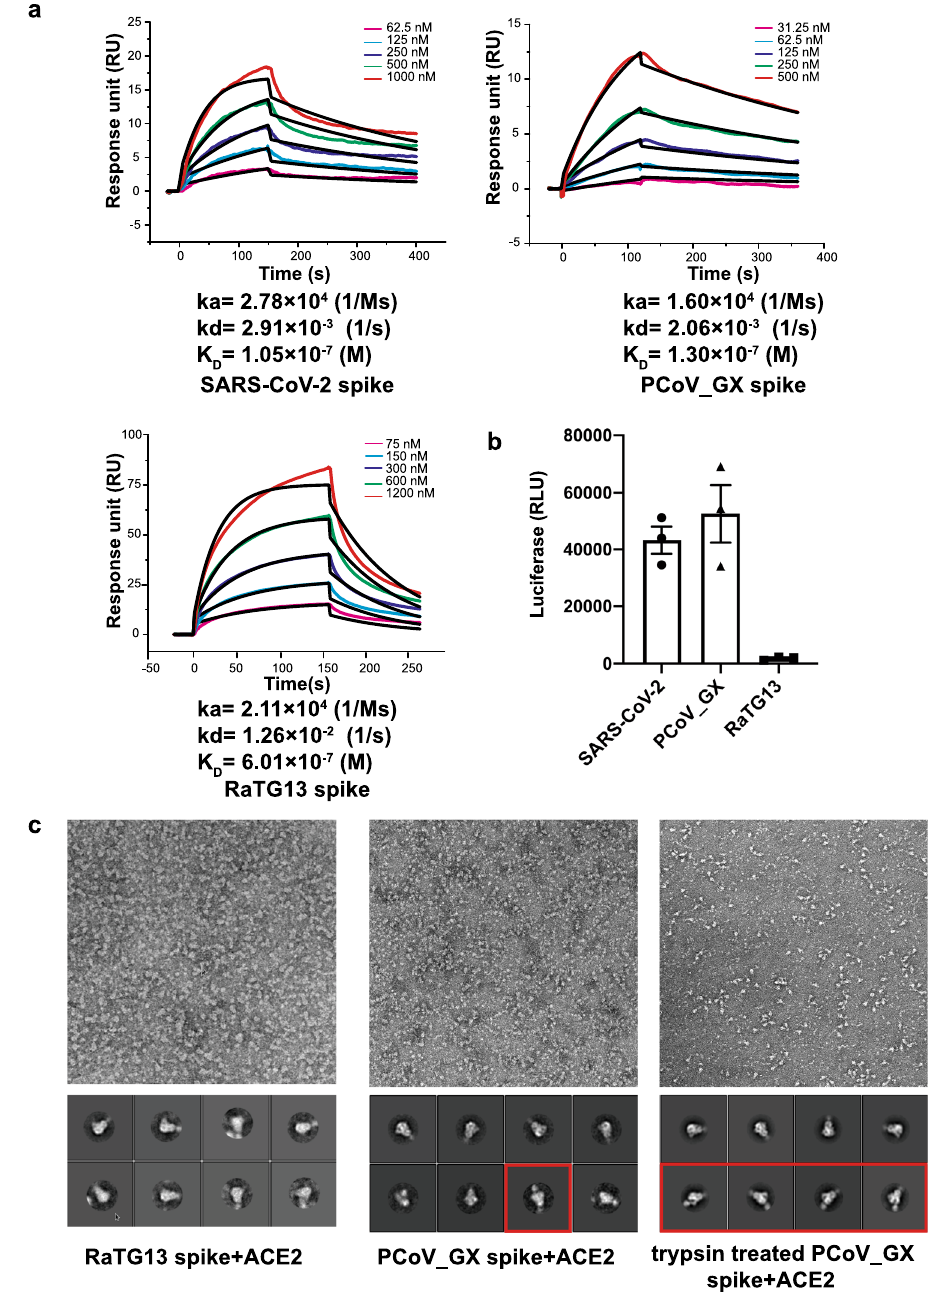
Fig. 6 Binding af fi nities of human ACE2 with different spikes and the cell entry of pseudoviruses. a Binding curves of immobilized hACE2 with the SARS-CoV-2, PCoV_GX, or RaTG13 spike. Data are shown as different colored lines and the best fi t of the data to a 1:1 binding model is shown in black. b The cell entry ef fi ciencies of pseudoviruses as measured by luciferase activity. SARS-CoV-2, PCoV_GX, and RaTG13 pseudoviruses were used to infect hACE2-transfected HEK 293 T cells. Data shown are from three independent experiments. Data are presented as mean values ± SEM. c The representative micrographs and 2D classi fi cation results of negative-staining EM. Both spikes were incubated with 4-fold molar ratio of hACE2. The red boxes show the complex of the PCoV_GX spike with